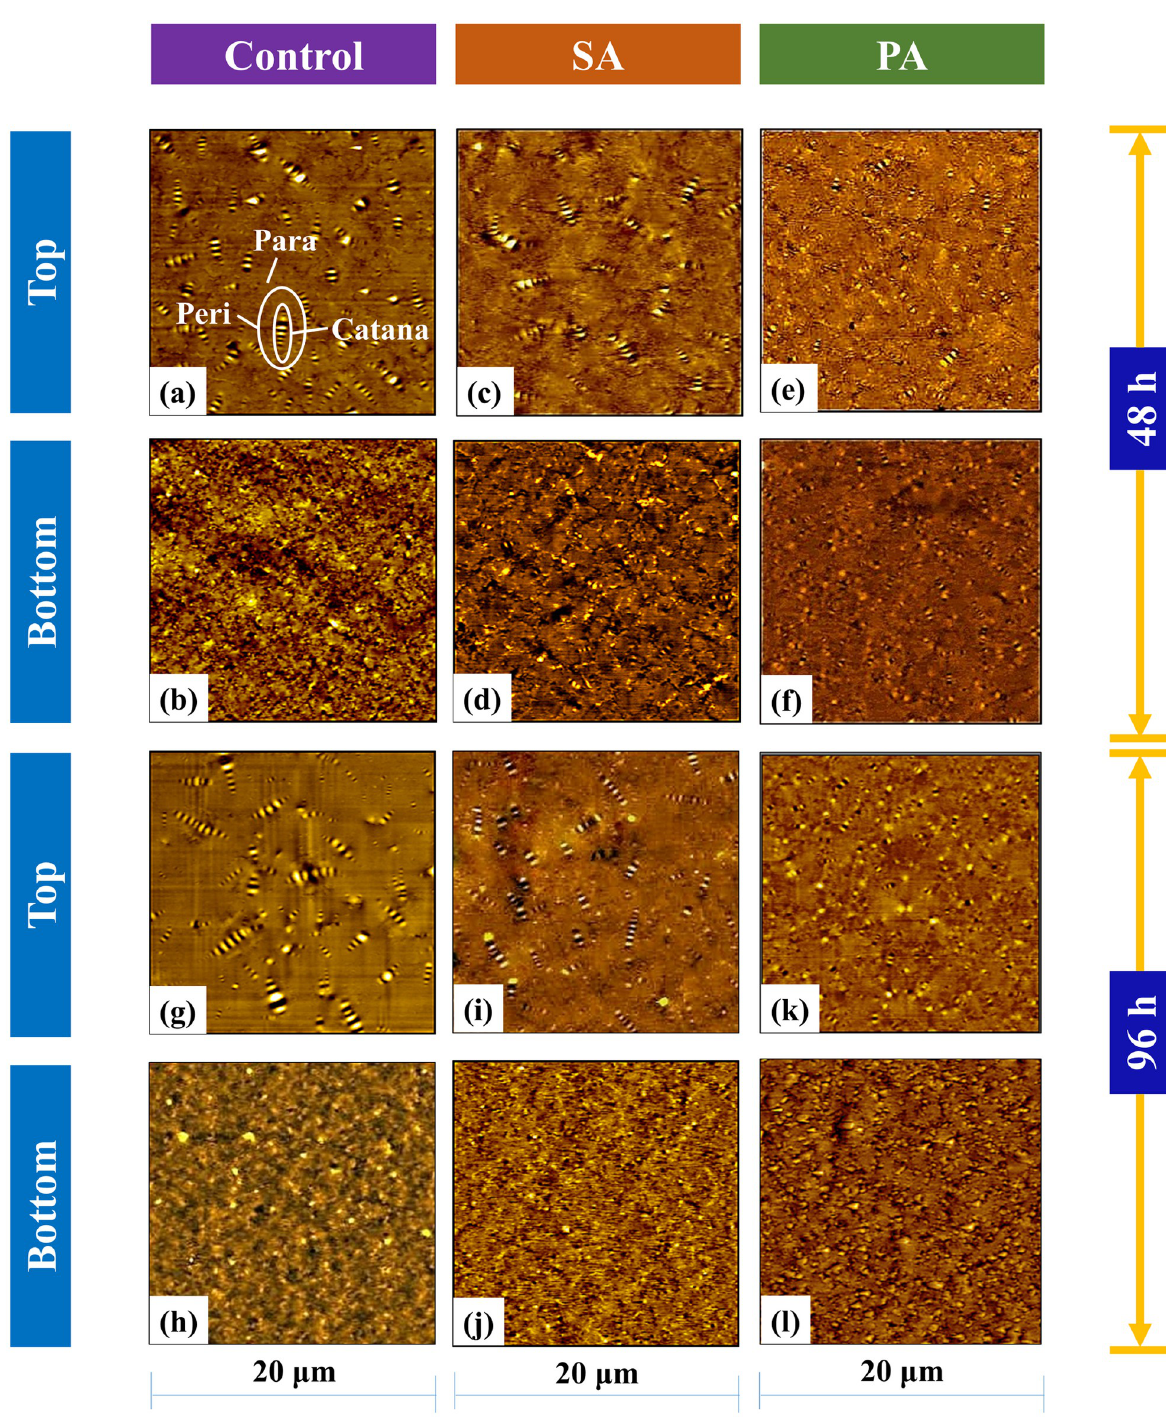
Fig 12. AFM micrographs after 48 h of thermal storage of binders: (a) R-top, (b) R-bottom, (c) RP6-top, (d) RP6-bottom, (e) RP6p-top, (f) RP6p-bottom; and after 98 h of thermal storage of binders: (g) R-top, (h) R-bottom, (i) RP6-top, (j) RP6-bottom, (k) RP6p-top, (l) RP6p-